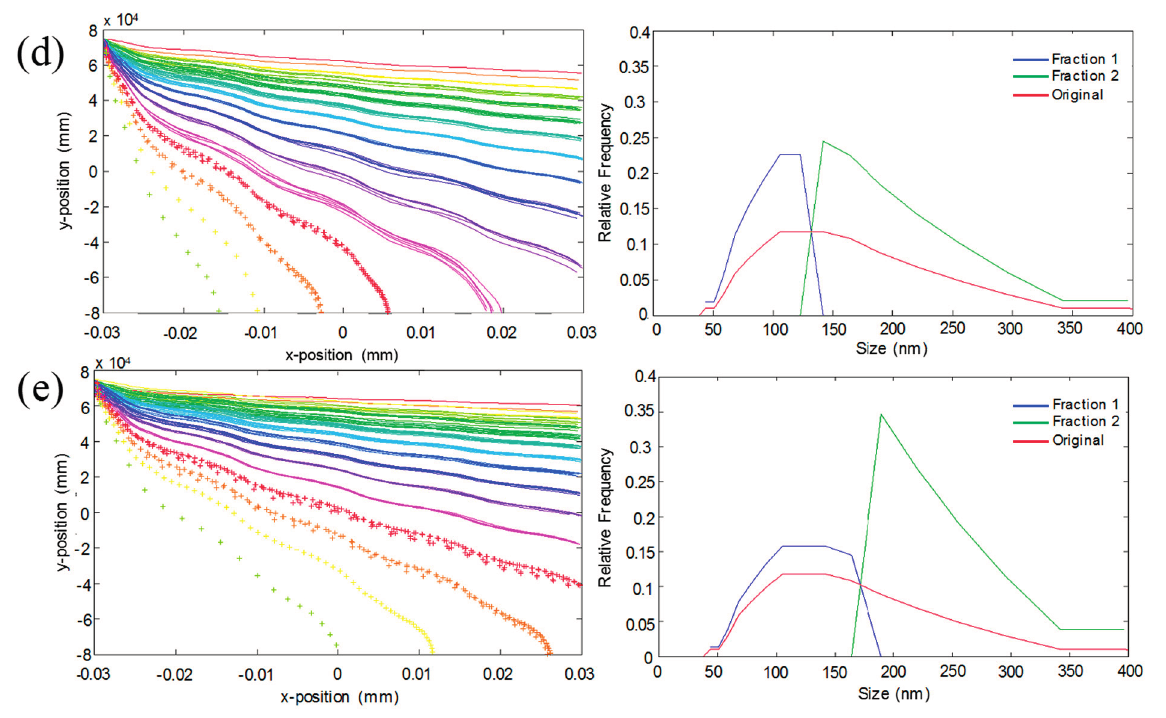
Figure 2. ( a ) Digital image of the sequence of magnets used for the simulation and validation experiments and the magnetic field map generated, using data from the manufacturer, for a series of five non-interacting ¼ ′′ diameter cylindrical magnets; ( b ) DLS size distribution of original iron oxide nanoparticle suspension; Predicted particle trajectories and resulting size distributions for original MNP (red), Fraction 1 (blue) and Fraction 2 (green) for magnet distances of ( c ) 7.5 mm; ( d ) 10 mm; and ( e ) 11.5 mm. Particle trajectory data sets based on MNP size of − 44, − 51, − 59, − 68, − 79, − 91, − 106, − 122, − 142, − 164, − 190, − 220, +255, +295, +342 and +396